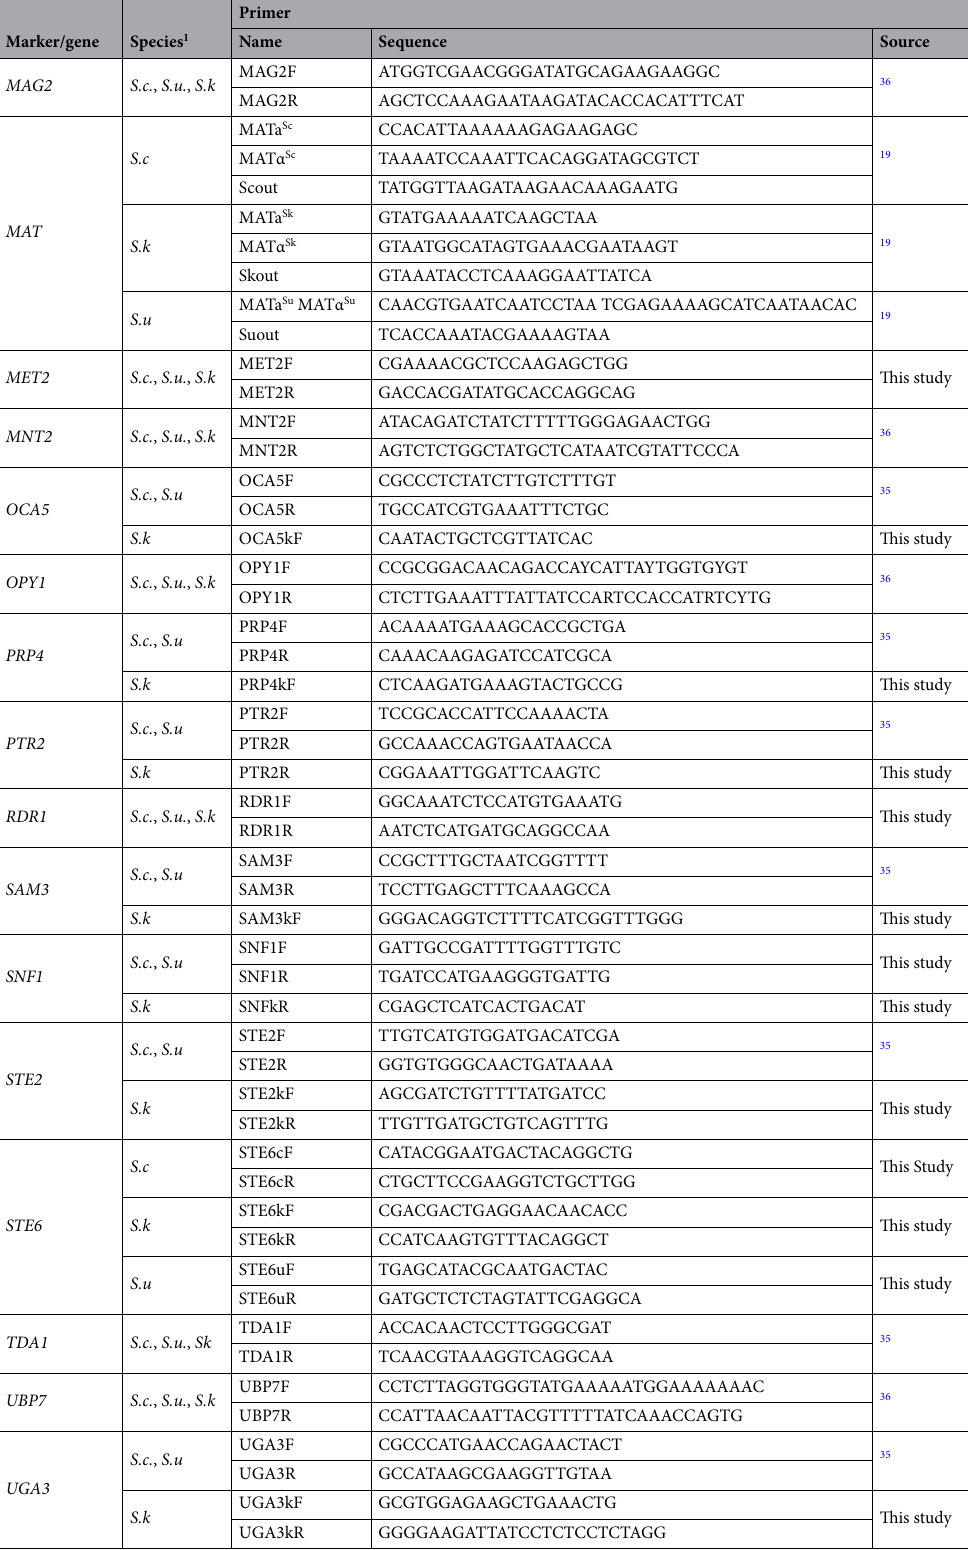
Table 3. List of primers used for the amplification of chromosomal markers. 1 S . c. S. cerevisiae , S.k . S. kudriavzevii , S.u. S.